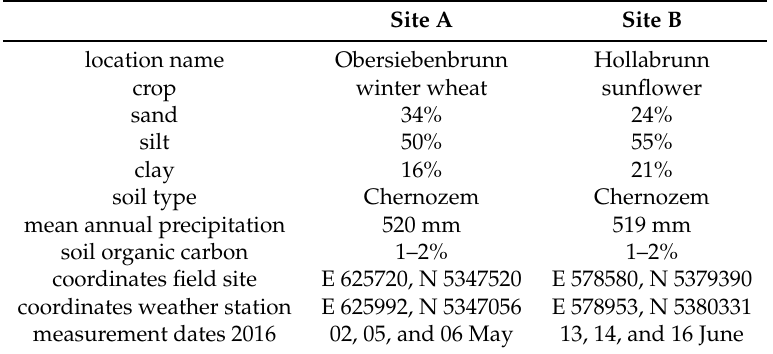
Table 1. Study site description. Grain size distribution classified as: 2 mm ≥ sand > 0.063 mm ≥ silt >